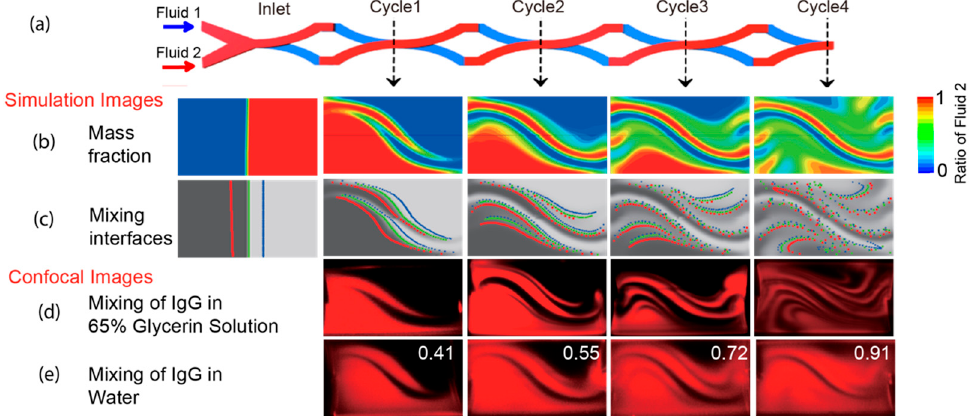
Figure 4. Simulation analysis and confocal images of the mixer in cross-sections of the first four cycles. ( a ) The schematic of input fluids and four outlet planes from 1–4 mixing cycles. ( b ) Simulated mass fraction distributions (calculated as the ratio of Fluid 2) of each outlet plane. ( c ) The growing number and length of mixing interfaces, which are traced and visualized using three sets of dots (colored in red, green, and blue) from the boundaries of two fluids at the inlet plane. ( d ) Confocal images of four outlet planes for mixing of IgG in 65% glycerin solutions. The interfaces are clearly visualized due to the slow protein diffusion in glycerin. ( e ) The confocal images of four planes for mixing IgG in water with the calculated mixing index labeled.